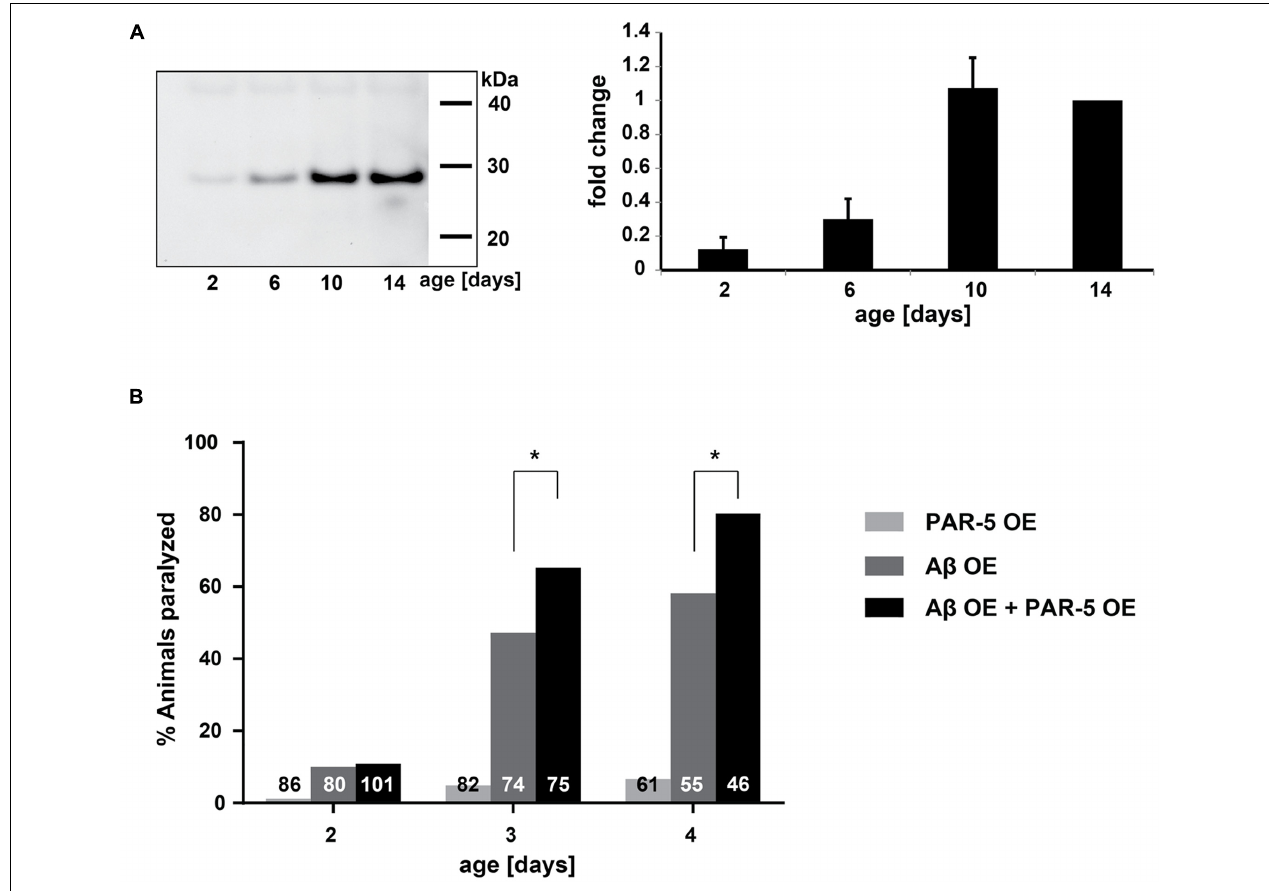
FIGURE 3 | Late-aggregation-prone protein PAR-5 accelerates A β toxicity in C. elegans . (A) Left: representative immunoblot detecting PAR-5 (14-3-3) in insoluble protein extracts from different ages. Right: immunoblot quantification of PAR-5. Band intensities were normalized to day 14. N = 4 (biological repeats), SEM depicted. (B) Paralysis levels of worms that overexpress PAR-5 (PAR-5 OE), A β (A β OE) or both (double transgenic, A β OE + PAR-5 OE). Shown are the percentages of worms paralyzed at different days. The numbers in the bars represent the total numbers of worms analyzed. Fisher’s exact test: A β OE vs. A β OE + PAR-5 OE, day 3 ∗ p = 0.032 and day 4 ∗ p = 0.019.